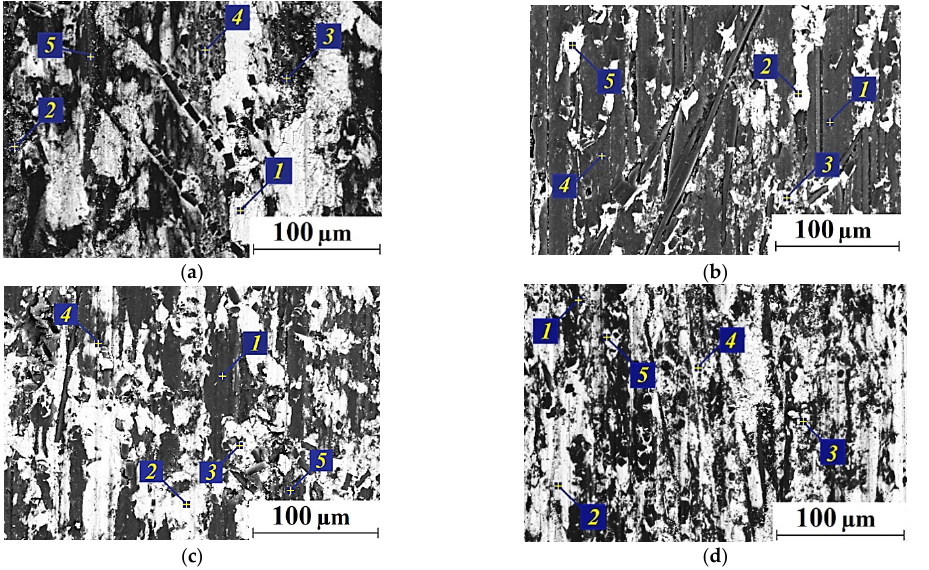
Figure 12. The optical micrographs of the wear tracks on the PI/10CCF ( a ), PI/10CCF/10PTFE ( b ), PI/10CCF/10Gr ( c ), and PI/10CCF/10MoS 2 ( d ) composites. The ‘severe’ mode ( P = 180 N, V = 0.3 m/s). Table 5. The results of EDS analysis in accordance with the labels in Figure 12.